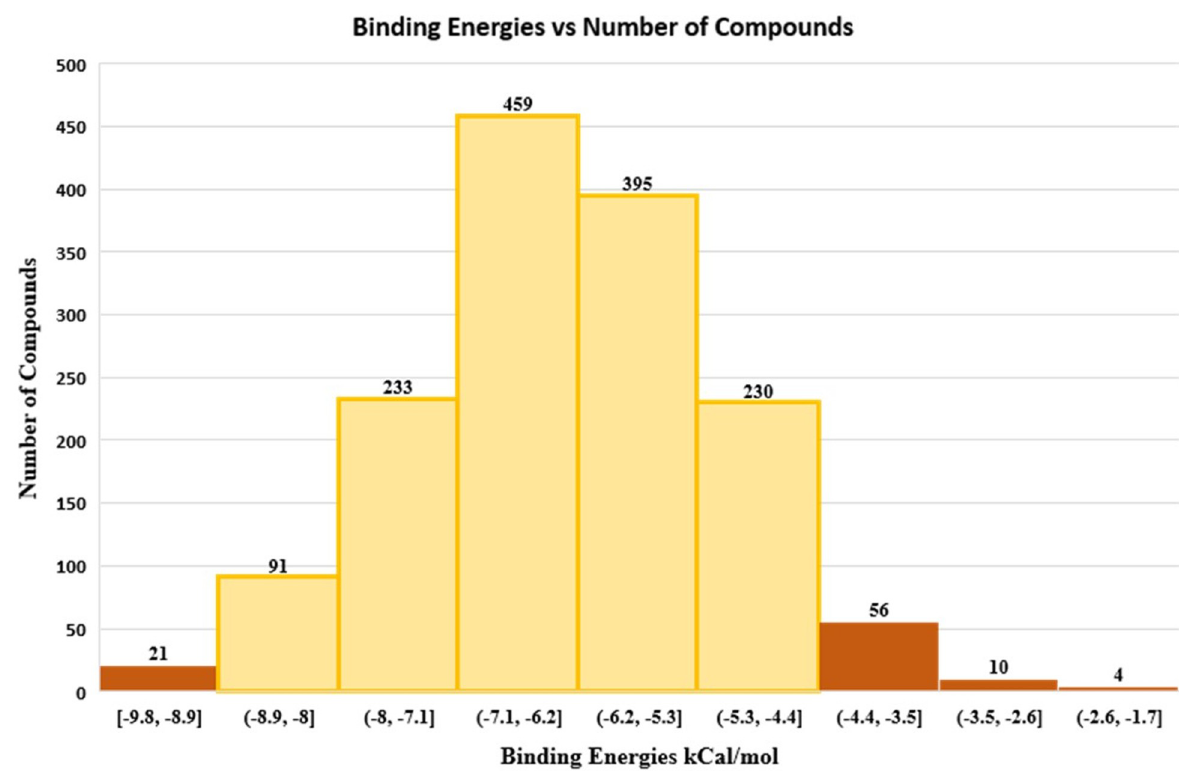
Fig 7. Virtual screening of ~1500 FDA approved drugs against prodigiosin synthetase. Results show that the most potential docked compounds within the range of -6.2 to -7.1 kcal/mol.